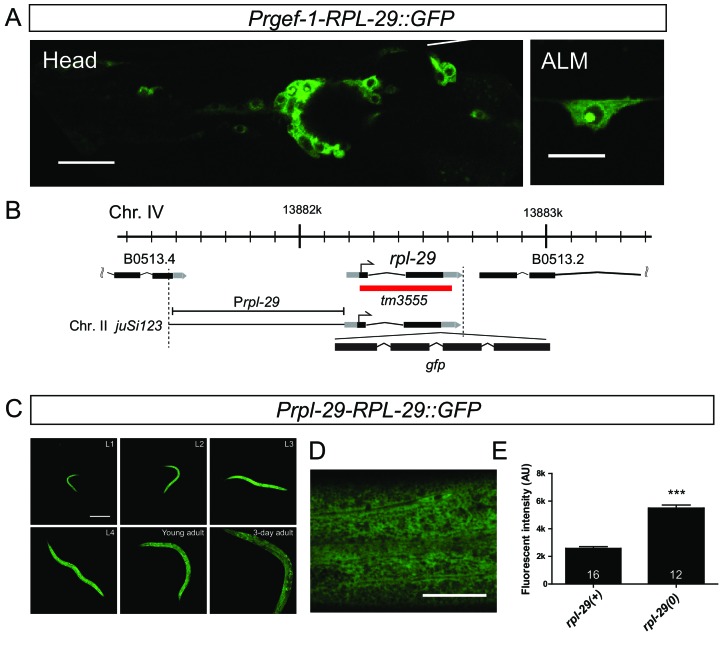
Ribosome visualization with RPL-29::GFP.(A) Pan-neuronal RPL-29 overexpression with juEx5243[Prgef-1-RPL-29::GFP] caused abnormal aggregates of RPL-29 in the nucleus. Head ganglia and mechanosensory ALM neurons are shown. Scale bars: 20 µm (left); 10 µm (right). (B) Schematics of the rpl-29 locus and a transgene. Black box: exon, Grey box: untranslated region, Red box: deletion. (C and D) The juSi123[rpl-29::GFP]; rpl-29(tm3555) strain showed the expression of RPL-29 in the cytosol (D, scale bar = 20 µm) throughout development (C, scale bar = 200 µm). (E) Quantification of the fluorescence intensity in the indicated genetic background. Error bars indicate S.E.M. Statistics: Student’s t-test, ***p<0.001.